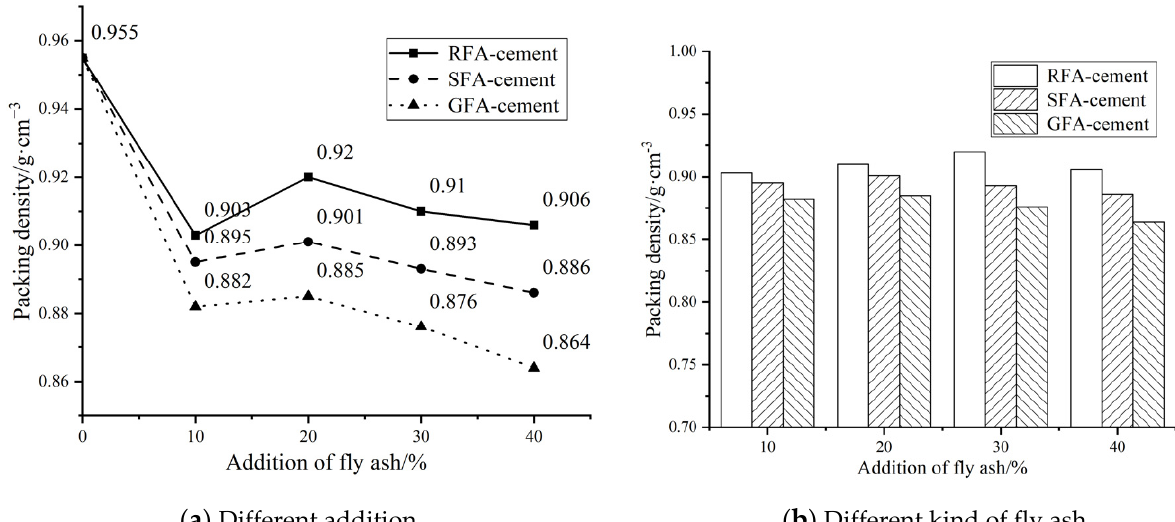
Figure 8. Dry packing density of fly ash-cement system.